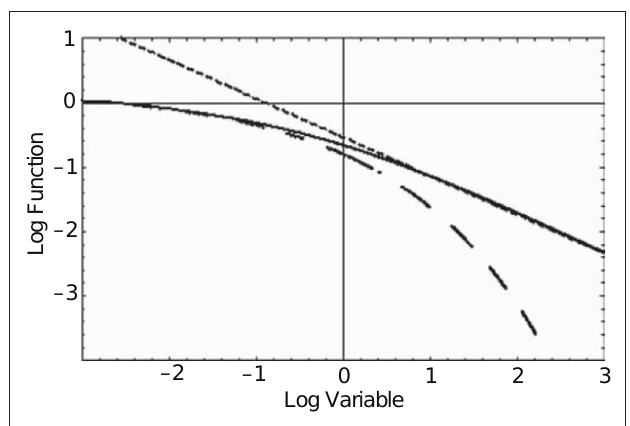
Figure 5 | The solid curve is the MLF, the solution to the fractional relaxation equation (eq. 29). The dashed curve (Eq. 30) is the stretched exponential (Kohlrausch–Williams–Watts Law) and the dotted curve (Eq. 31) is the inverse power law (Nutting